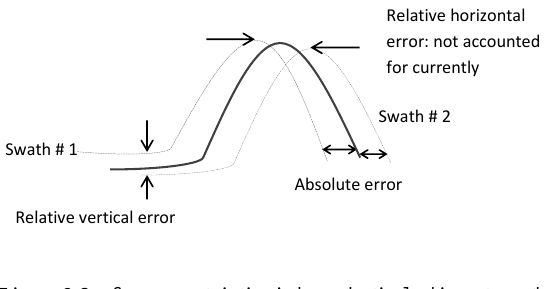
Figure 2 Surface uncertainties in hypothetical adjacent swaths. Profile of nominal surface is shown as solid line while the surface defined by swath # 1 and swath # 2 are shown as dotted lines